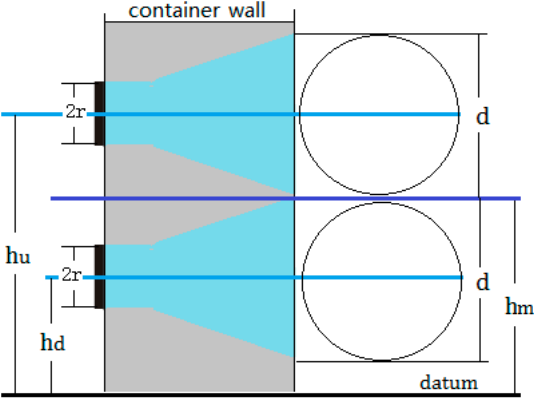
Figure 5. Determination of two critical positions of the energy circle and calibration of liquid level.